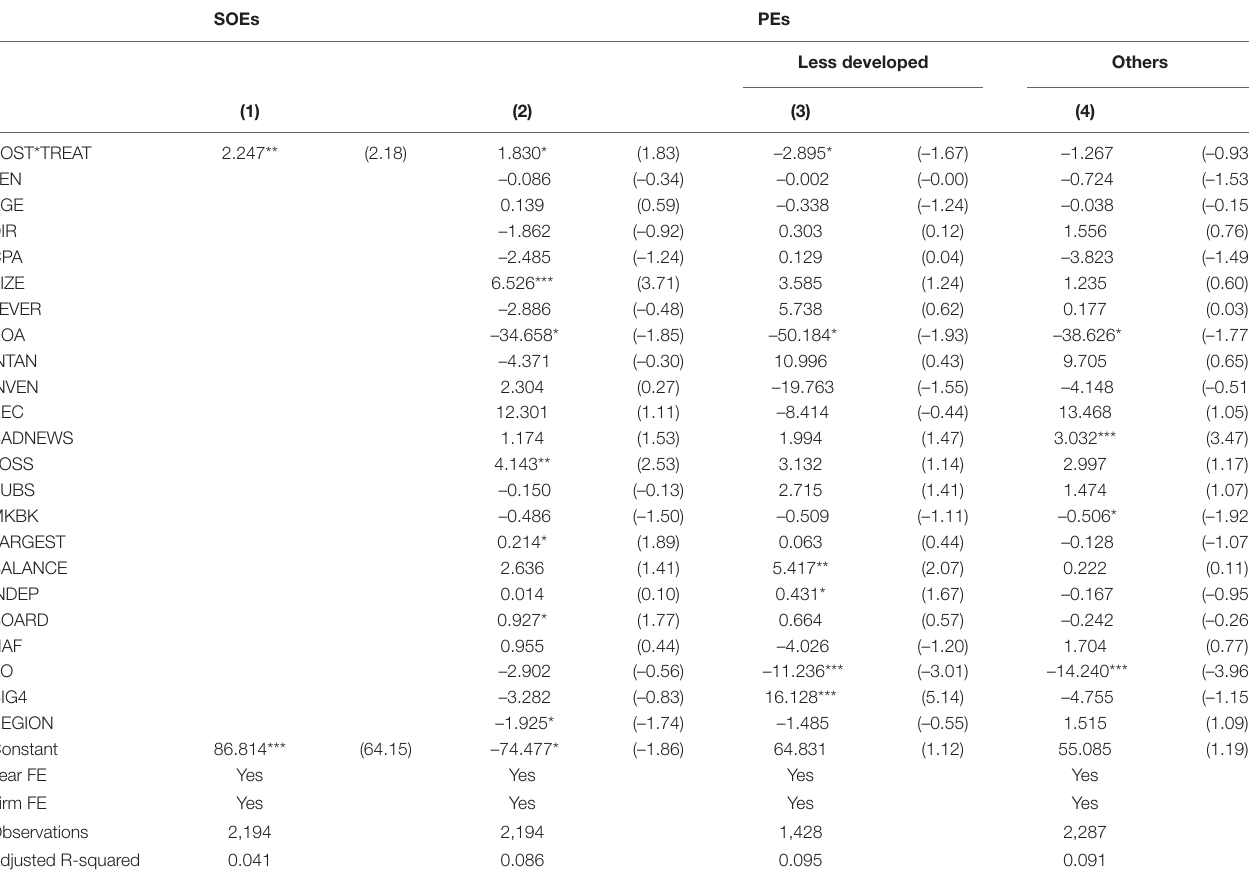
TABLE 7 | DID tests for CFO functional diversification and timeliness